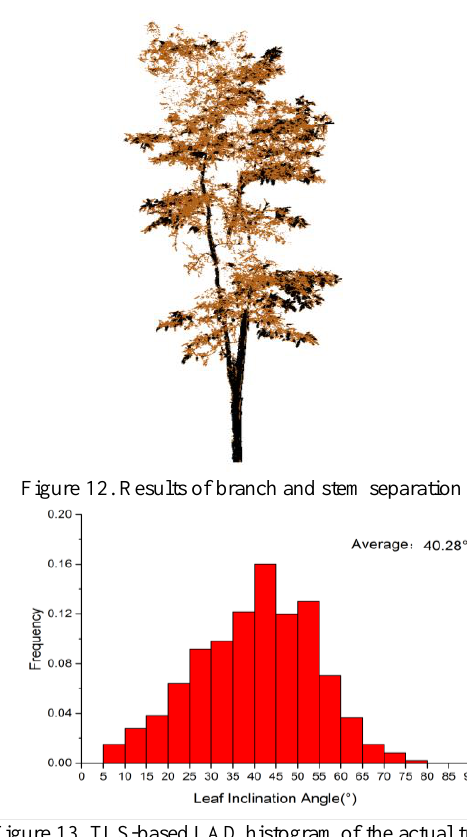
Figure 13. TLS-based LAD histogram of the actual